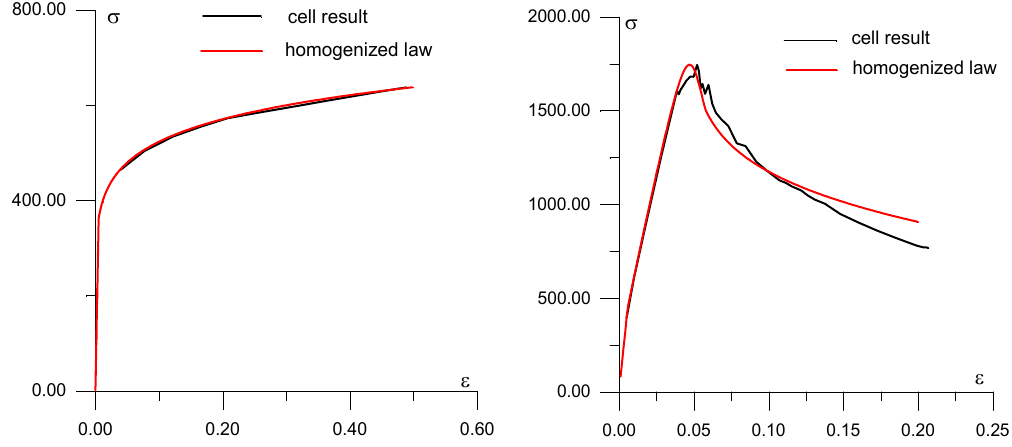
Figure 6: Global cell response compared with eq. (1-6) for the two load cases.